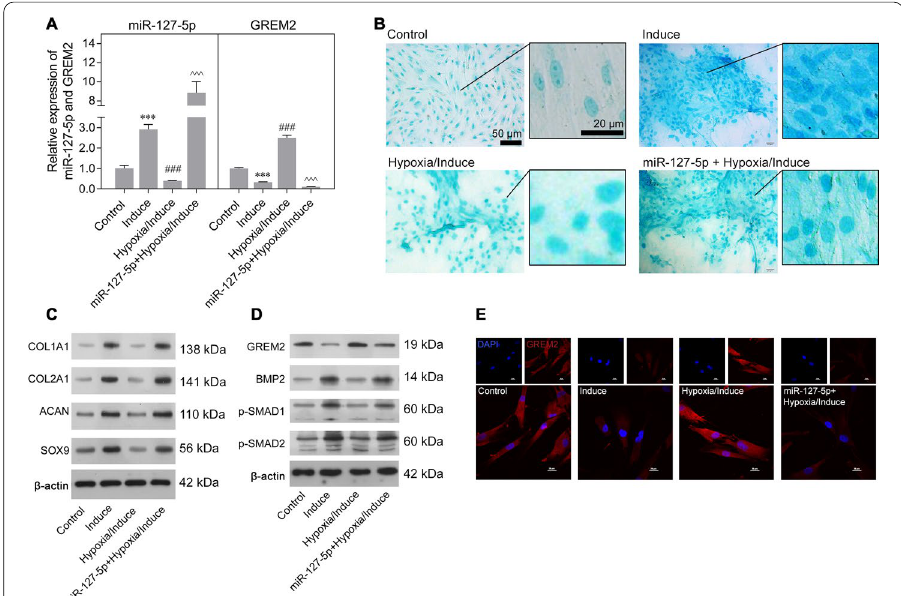
Fig. 5 Overexpression of miR-127-5p promoted chondrogenic differentiation of rMSCs by regulating GREM2-mediated SMAD-dependent BMP signaling. The rMSCs were transfected with miR-127-5p mimics, followed by hypoxia intervention (1% O 2 ) and induction of chondrogenic differentiation for 14 days. A MiR-127-5p and GREM2 expression levels were determined by quantitative real-time PCR analysis. Results are expressed as mean standard deviation of data obtained from three independent experiments. *** p < 0.001, ± compared with control; ### p < 0.001, compared with induction group; p < 0.001, compared with hypoxia/ induction; B Images from Alcian blue staining assays of rMSCs. C Levels of COL1A1, COL2A1, SOX9, and ACAN protein expression were detected in rMSCs. D Levels of GREM2, BMP2, p-SMAD1, and p-SMAD2 protein expression in rMSCs were detected by western blotting. E GREM2 protein expression in rMSCs was detected by